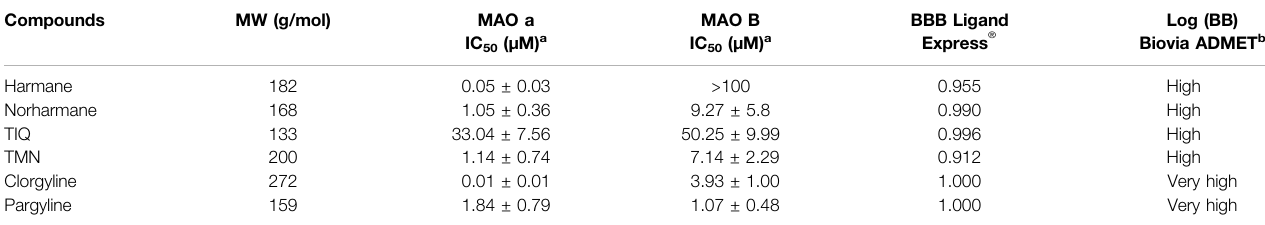
MAO B BBB Ligand Log (BB) IC 50 ( μ M) a IC 50 ( μ M) a Express ® Biovia ADMET b